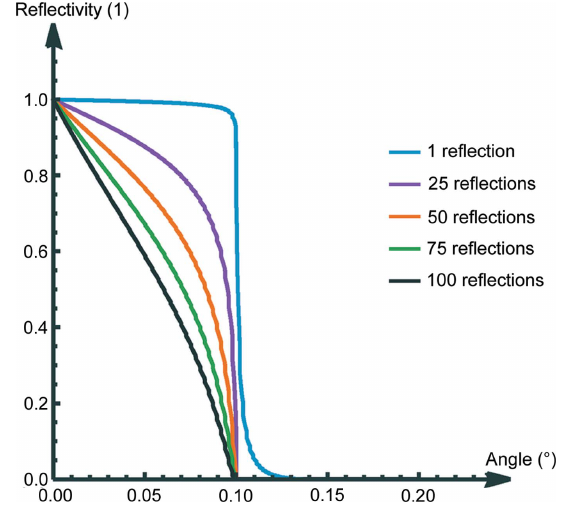
Figure 6 Calculated total reflectivity for a reflection on an SiO 2 surface for multiple reflections of X-rays with an energy of 17.4 keV.